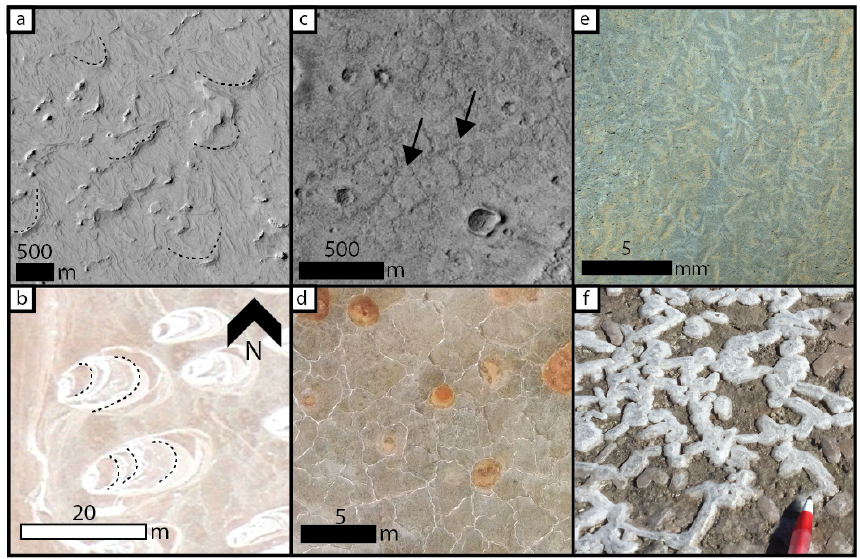
Figure 9. Mars surface feature analogs to Deep Springs playa. (a) Terrain on Mars resembling the crescent features observed in Deep Springs (HiRISE image ESP_071800_1805). (b) Bright concentric features in Deep Springs resembling similar crescent-shaped features on Mars. Dashed black lines show nested, concentric lineations across each feature. Image courtesy of Google Earth (© Google Earth 2022). (c) Polygonal fractures found in the interior of Barth crater, a paleo-lake on Mars (CTX image: G20_025939_1864_XI_06N334W). (d) Polygonal fractures observed in Deep Springs as the playa’s surface dries out. (e) Mosaic of MAHLI images from sol 809 showing jarosite crystals. (f) Evaporite crystals found in several depressions in Deep